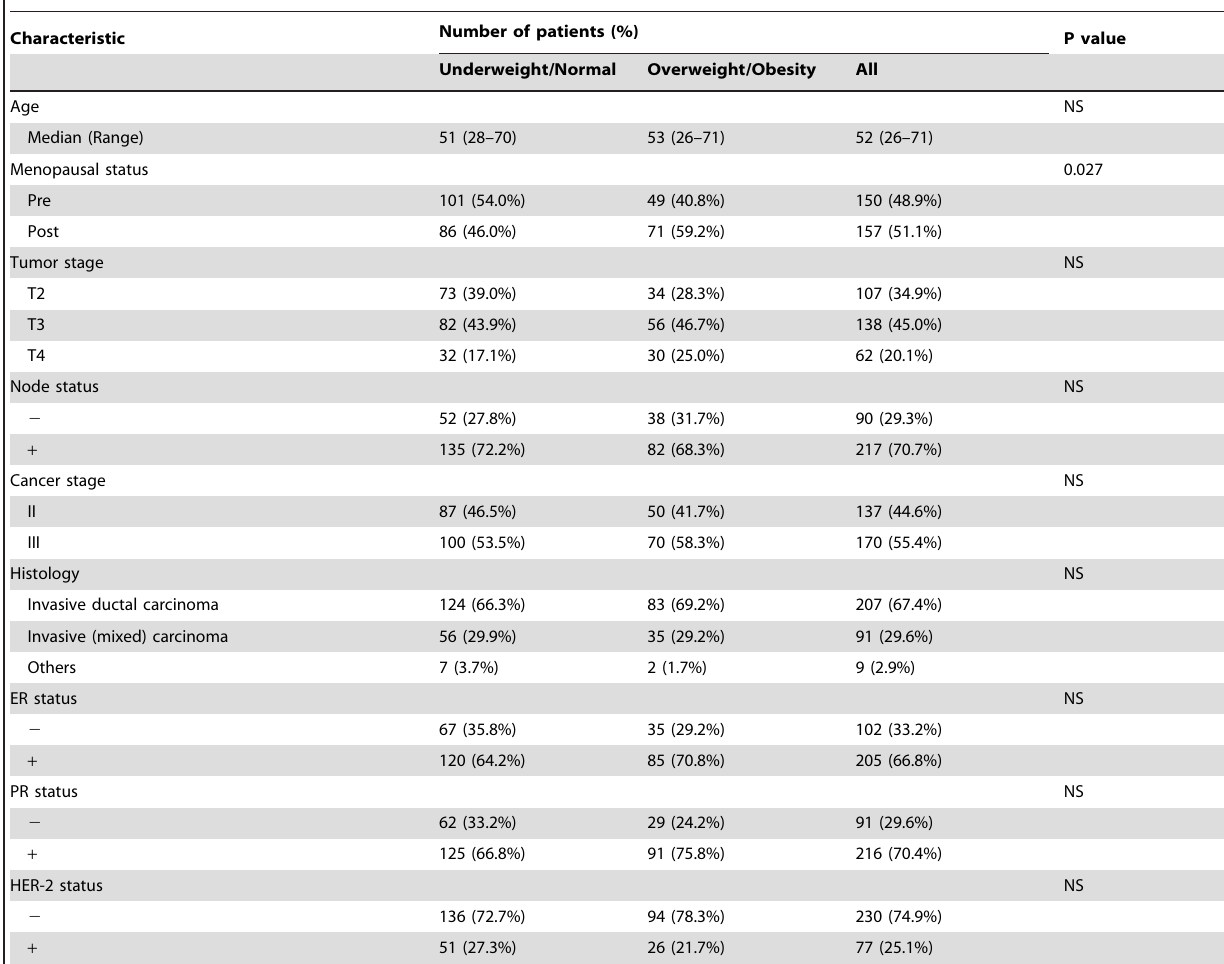
Table 1. Patient characteristics according to